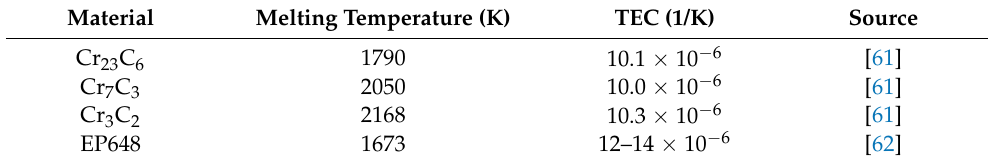
Table 1. Thermophysical properties of some precipitations and base material at normal conditions.